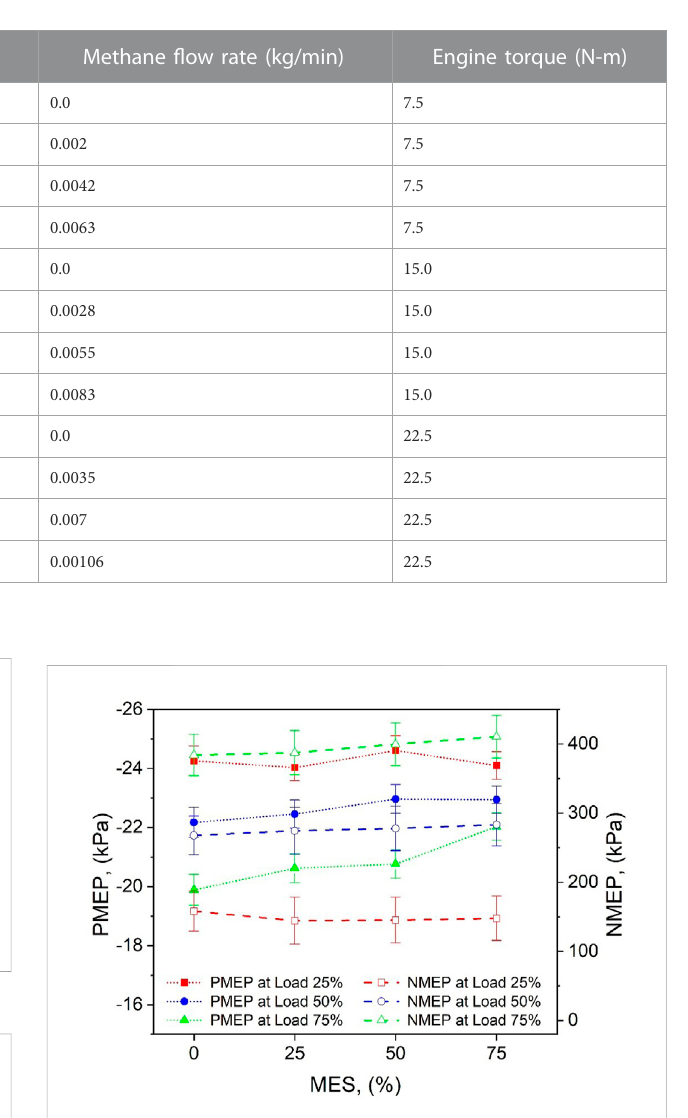
FIGURE 4 Variation of pumping mean effective pressure and net mean effective pressure with respect to diesel fuel with MES level at different